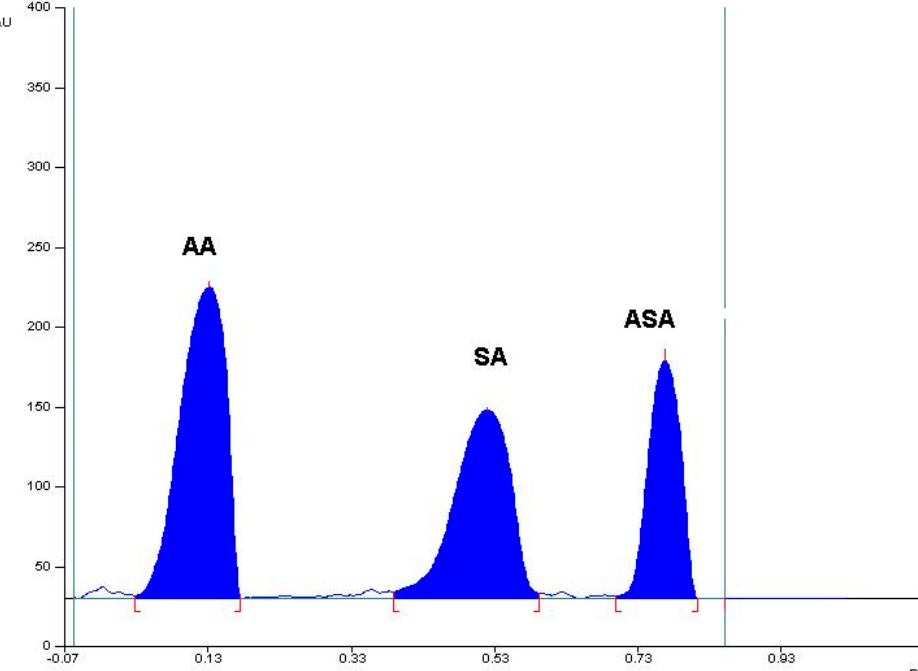
Figure 1. The densitogram obtained from ascorbic acid (AA), acetylsalicylic acid standards (ASA) spiked with a related substance to ASA, namely salicylic acid (SA) (mobile phase B4: chloroform: ethanol 96%: glacial acetic acid (5:4:0.03, v/v/v )).